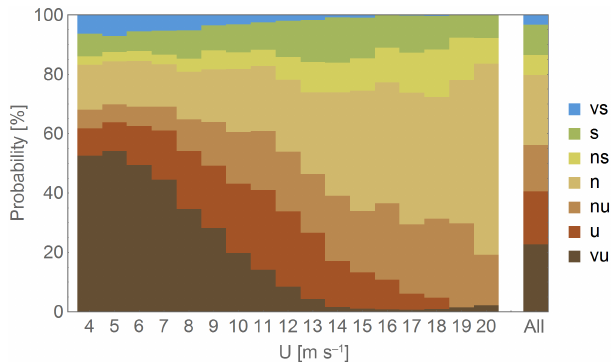
Figure 2. Distribution of seven stability classes from very stable (vs) to very unstable (vu) based on 2.5 years of WRF simulations for wind speeds between 4 and 20ms − 1 and the distribution for all wind speeds labeled